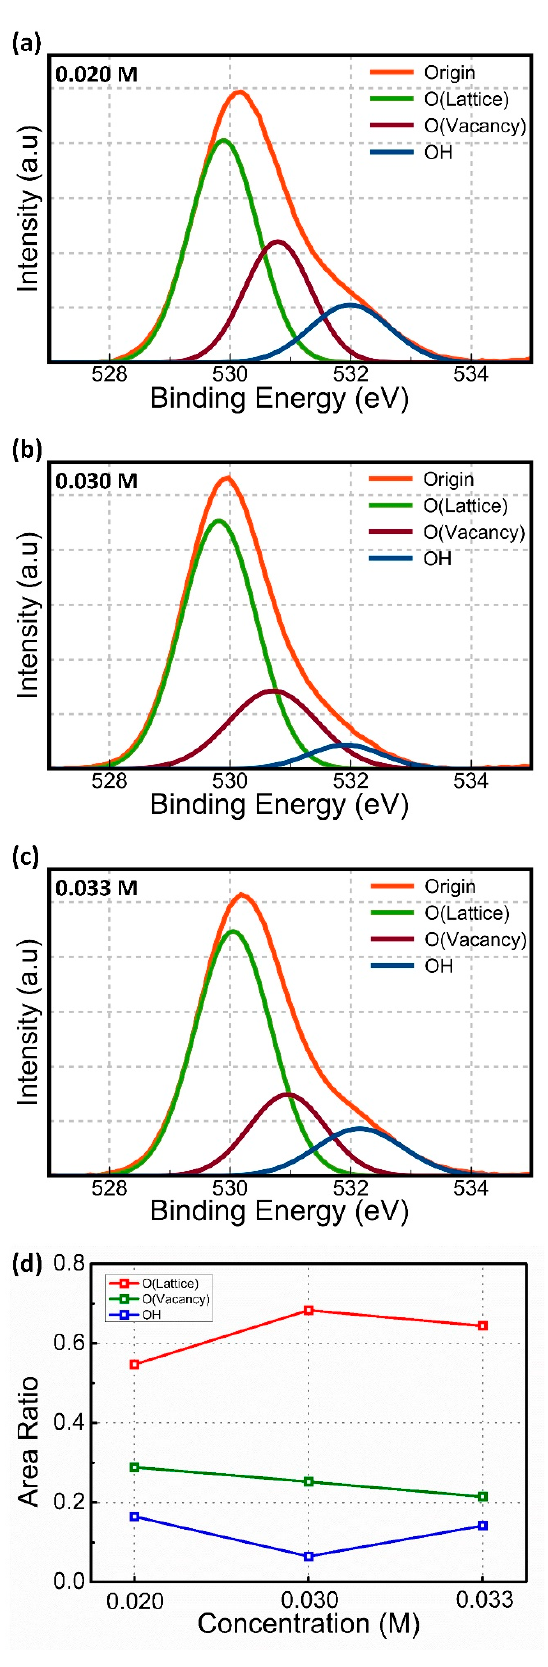
Figure 3. ( a – c ) O1s XPS spectra of SnO 2 thin films and ( d ) O1s composition as a function of precursor concentrations.